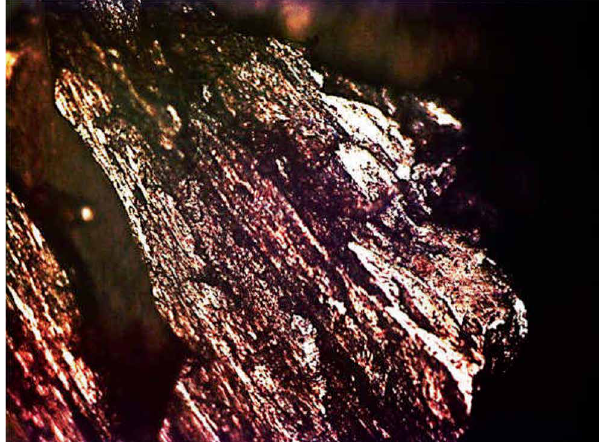
Figure 14: Metal squeeze out due to high load (2300 N) 0.5%